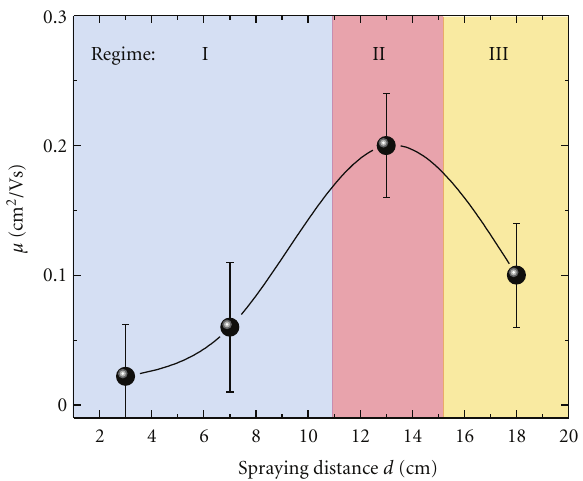
Figure 4: Measured field-e ff ect mobility ( μ ) as a function of the spraying distance (d). Three distinct regimes can be